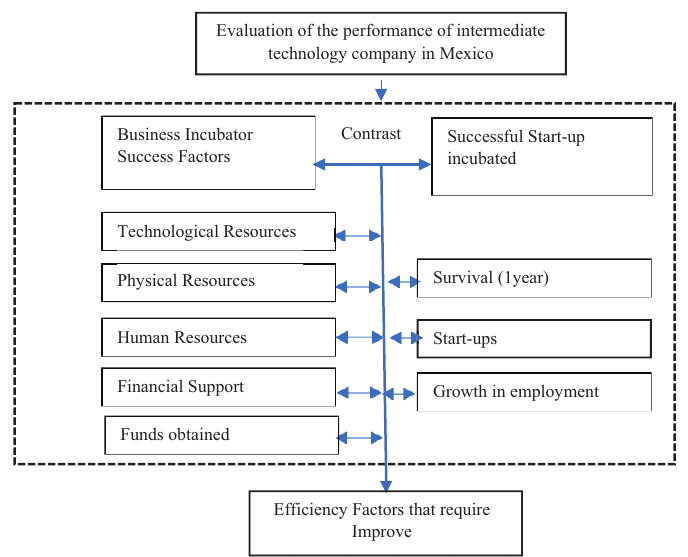
Figure 1. Model of contrast of the ef fi ciency of the Mexican incubators of intermediate